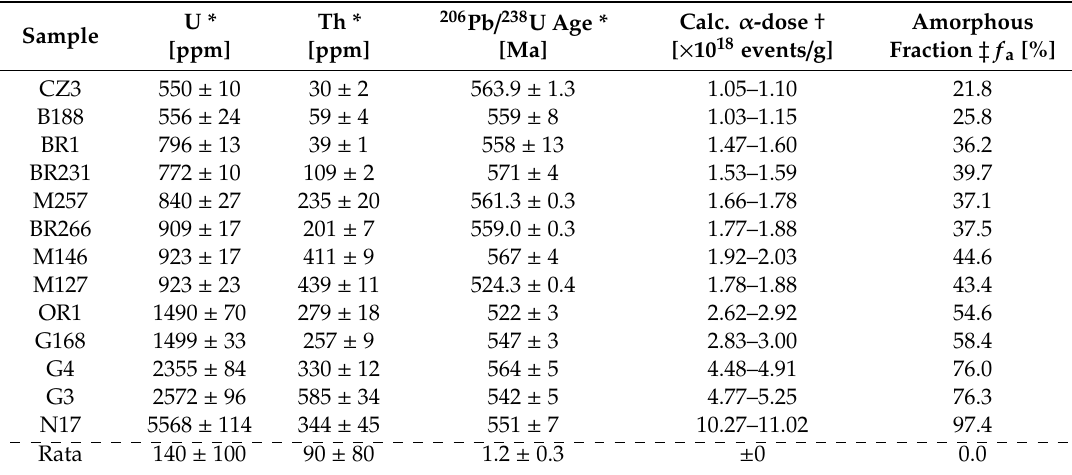
Table A1. Uranium and thorium concentrations, ages, calculated α -doses, and the amorphous fraction f a of various homogeneous, Sri Lankan zircon crystals and a damage-free reference from the Ratanakiri district, Cambodia